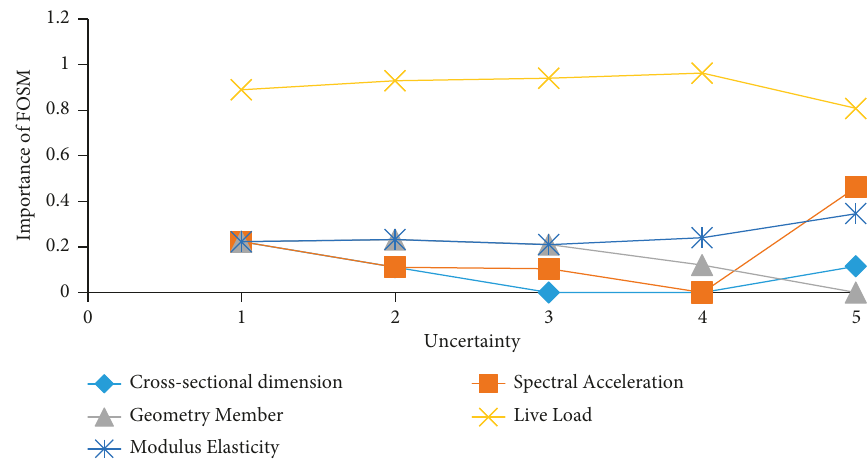
Figure 19: Measure the importance of uncertainties in